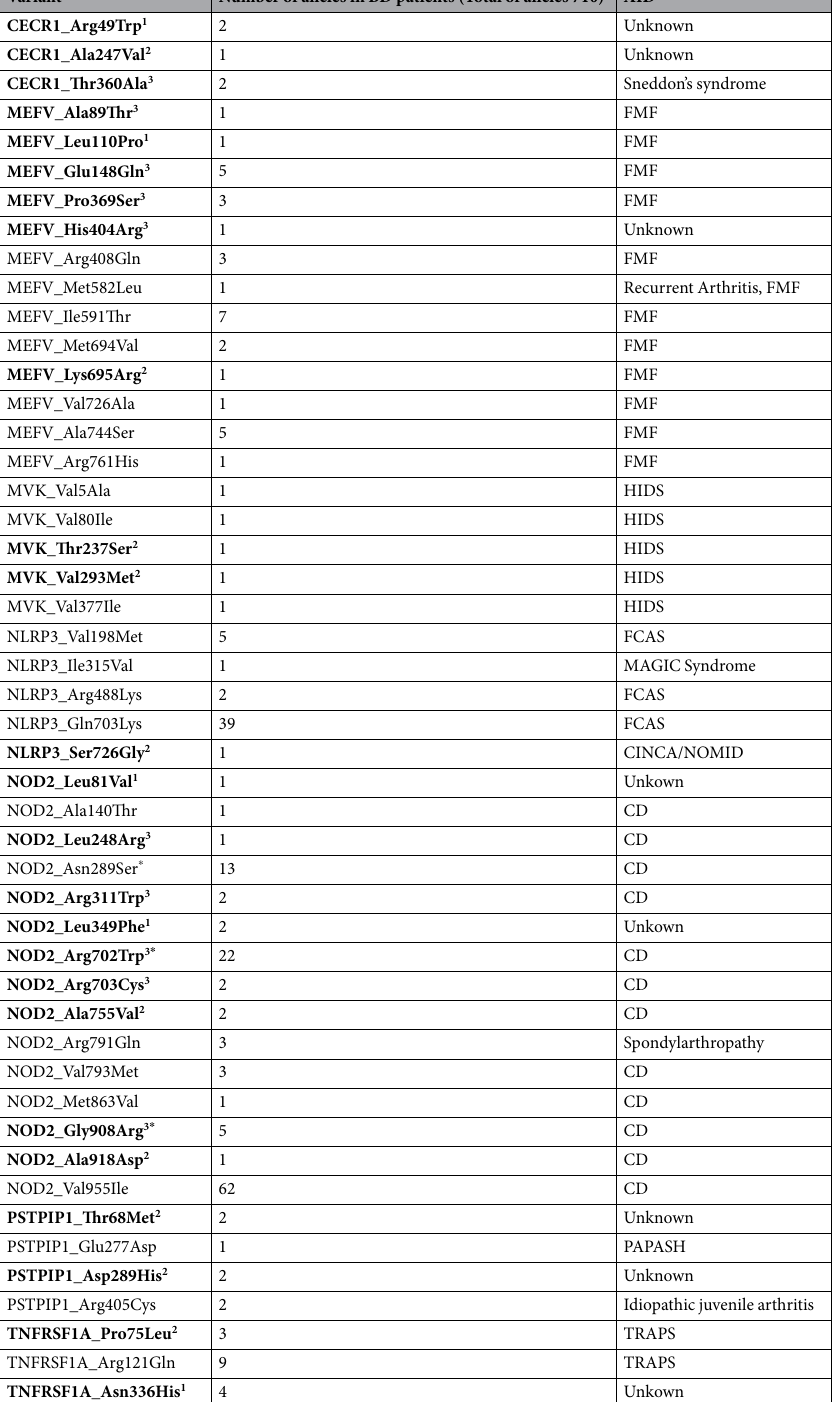
Table 3. Number of alleles of the different variants found in our BD patients reported in clinical database and/ or pathogenic according to PolyPhen2 and/or SIFT. Variations pathogenic according to the bioinformatic prediction are displayed in bold. 1 SIFT, 2 PolyPhen2 and 3 both. * NOD2 loss of function variants reported as associated to risk in CD but as possible protective in